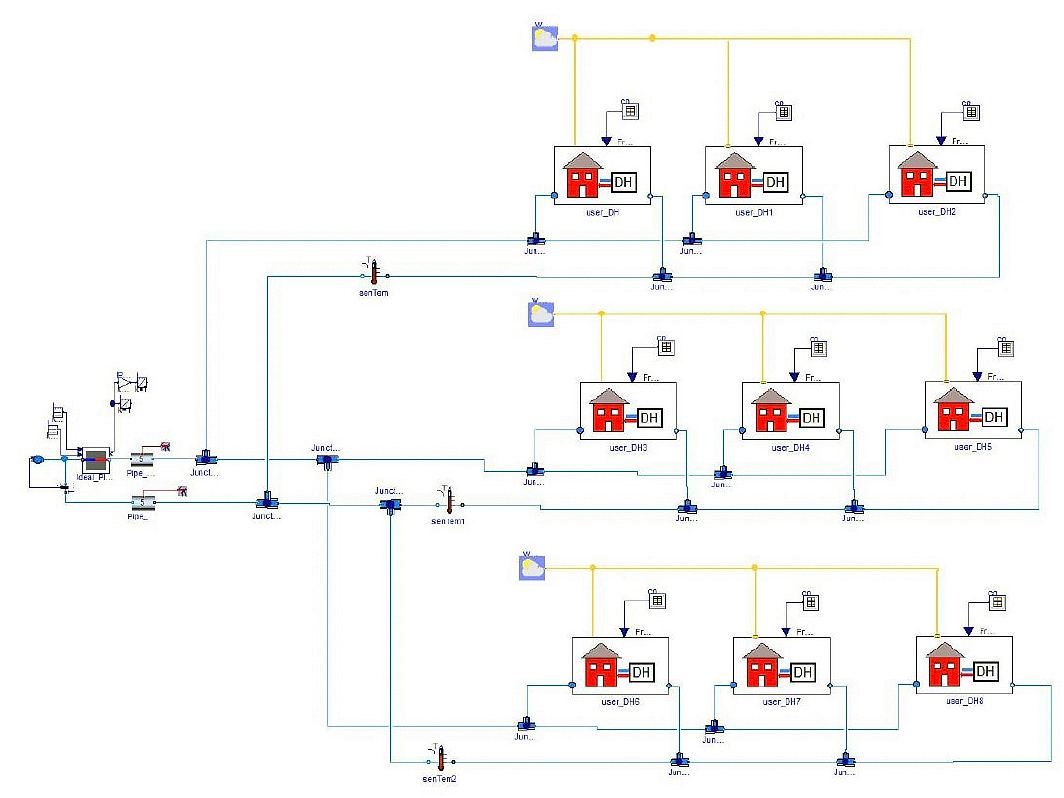
Figure 2. The simulation model for the district heating system, developed in Modelica–Dymola